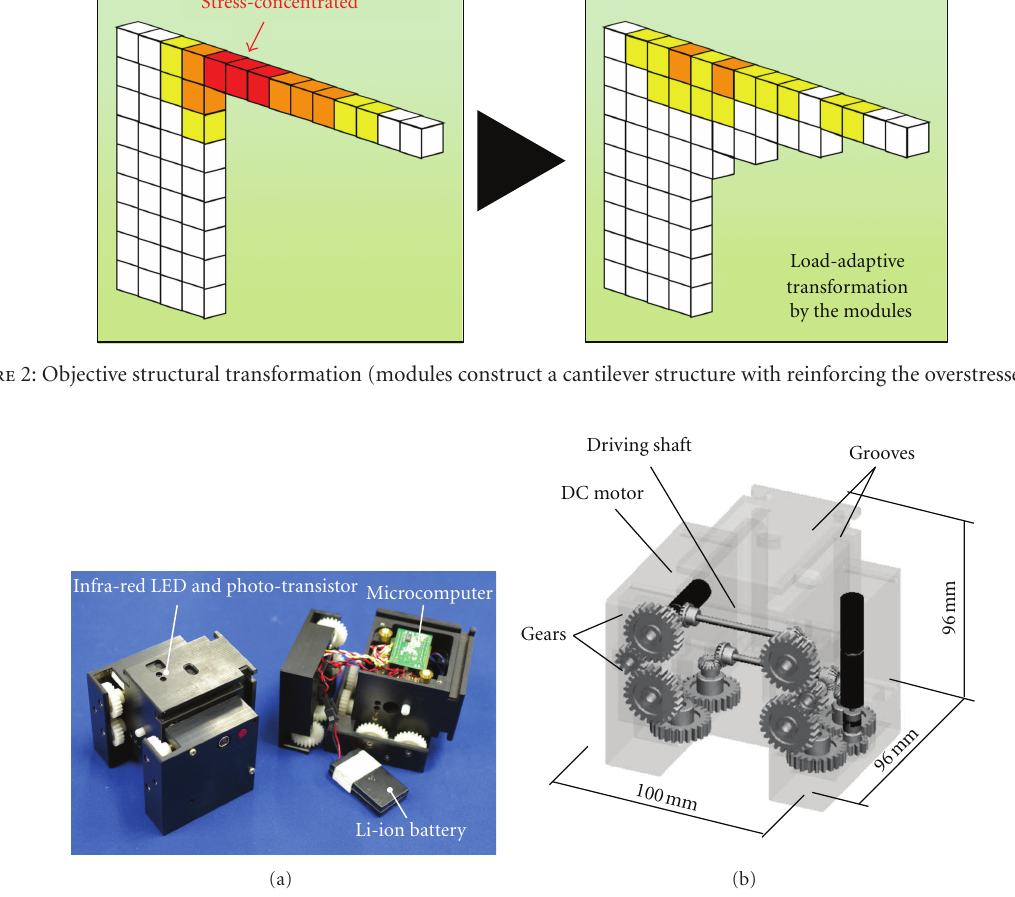
Figure 3: Mechanism of the modules of CHOBIE II (a) outside/inside views of the module, (b) slide motion